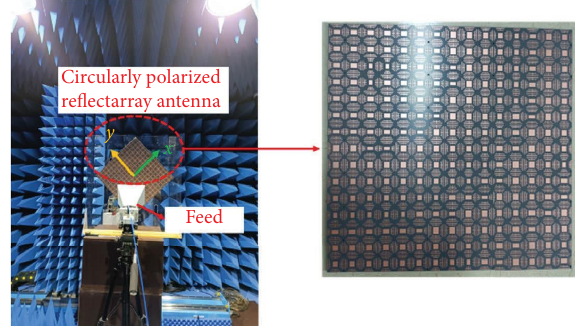
Figure 16: Refect array antenna physical measurement diagram.